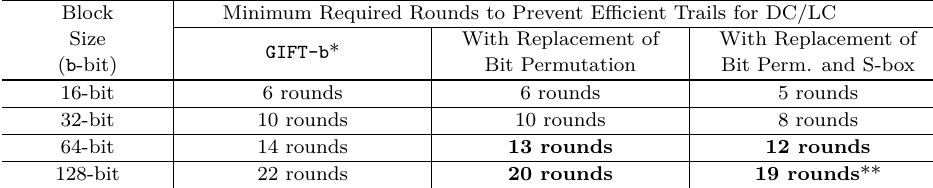
Table 2: Summary of Minimum Required Rounds for BOGI-Based